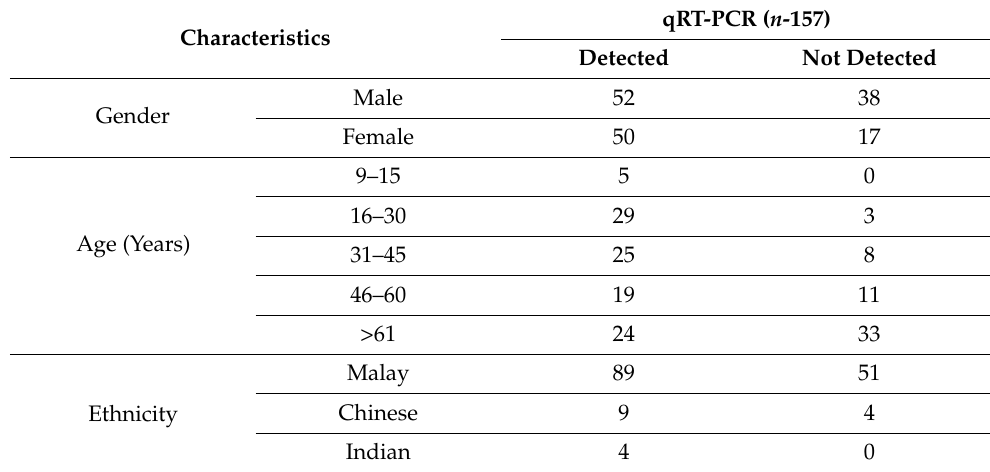
Table 2. Demographic characteristics of study participants.